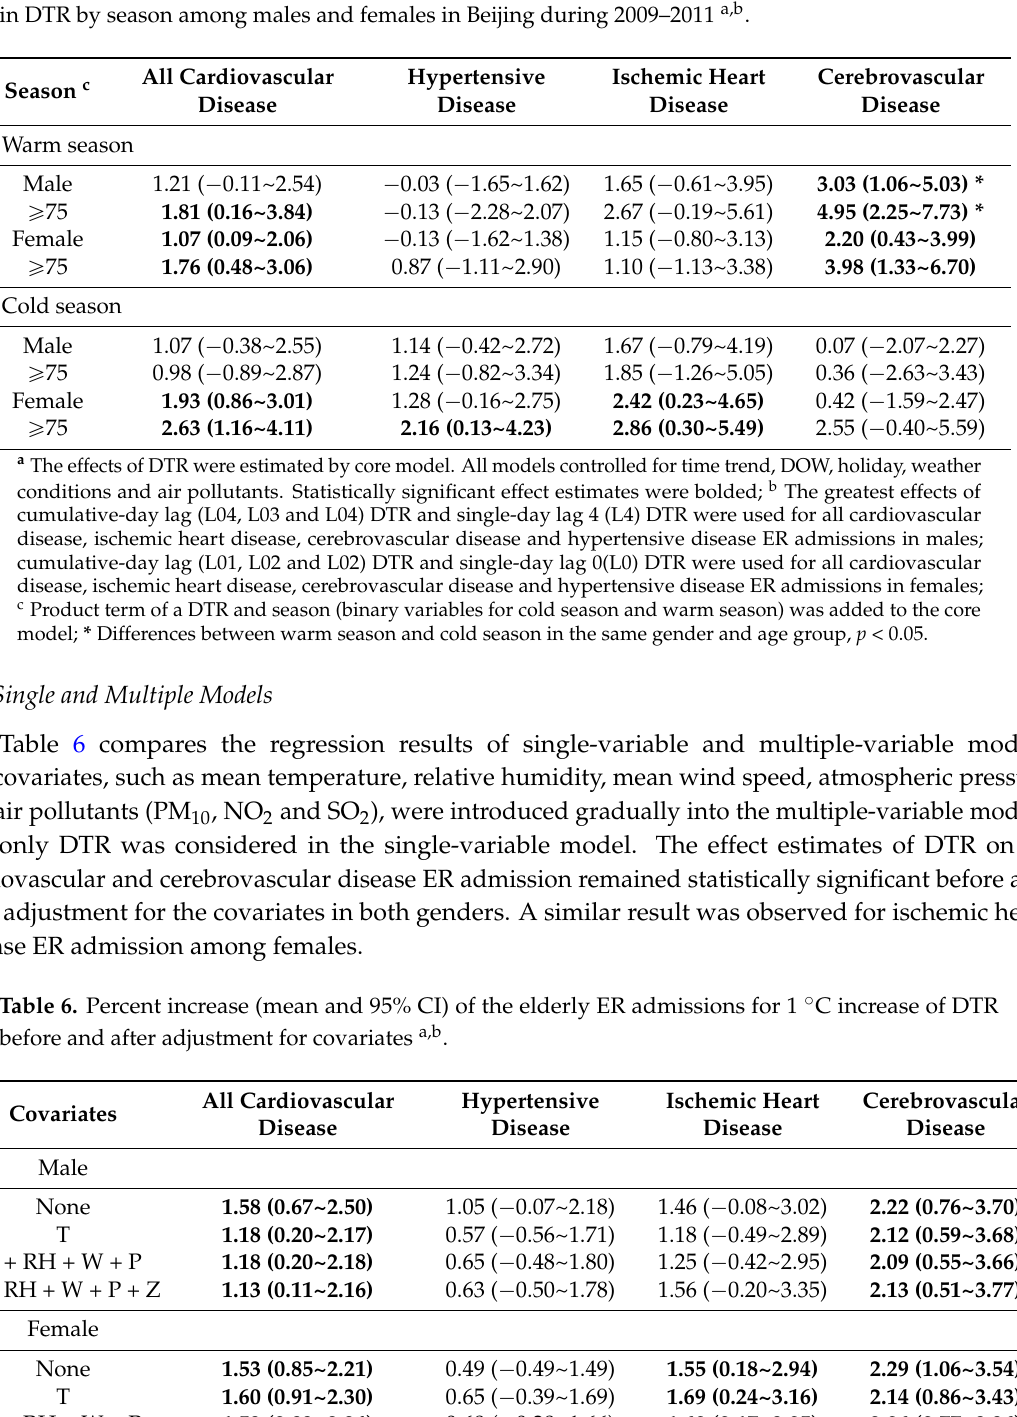
Table 5. Percent change (mean and 95% CI) of the elderly ER admissions associated with a 1 ˝ C variation in DTR by season among males and females in Beijing during 2009–2011 a,b .